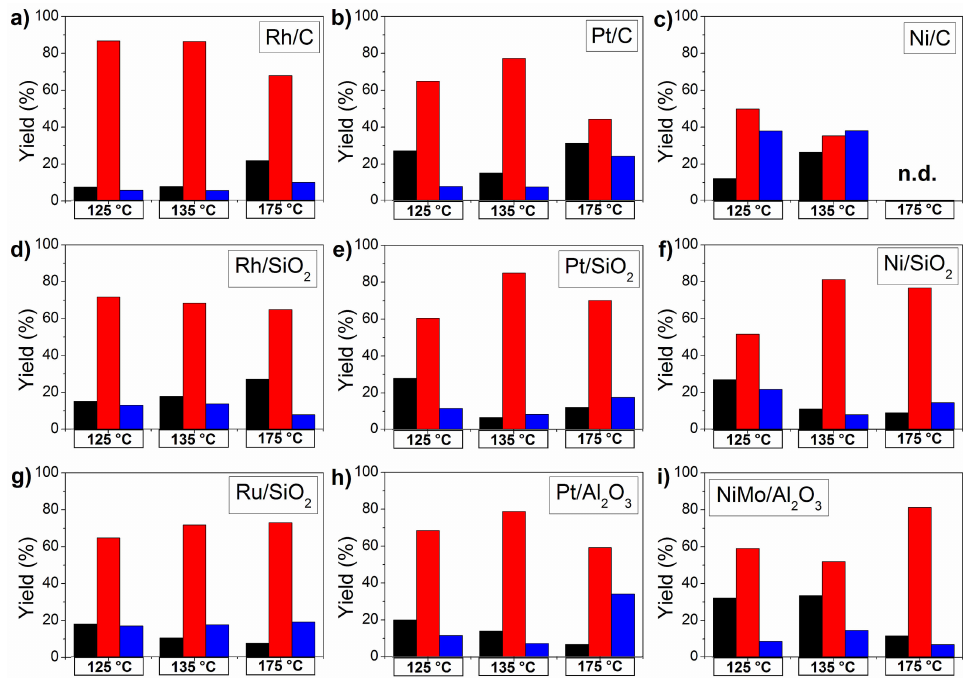
Figure 6. Selectivity to representative group of products over each catalyst: ( a ) Rh/C, ( b ) Pt/C, ( c ) Ni/C, ( d ) Rh/SiO 2 , ( e ) Pt/SiO 2 , ( f ) Ni/SiO 2 , ( g ) Ru/SiO 2 , ( h ) Pt/Al 2 O 3 , and ( i ) NiMo/Al 2 O 3 . Black: partially or completely deoxygenated short chain products (chain length < C6). Red: cyclic products (mostly furanic compounds). Blue: long chain (oligomerized) products (chain length >